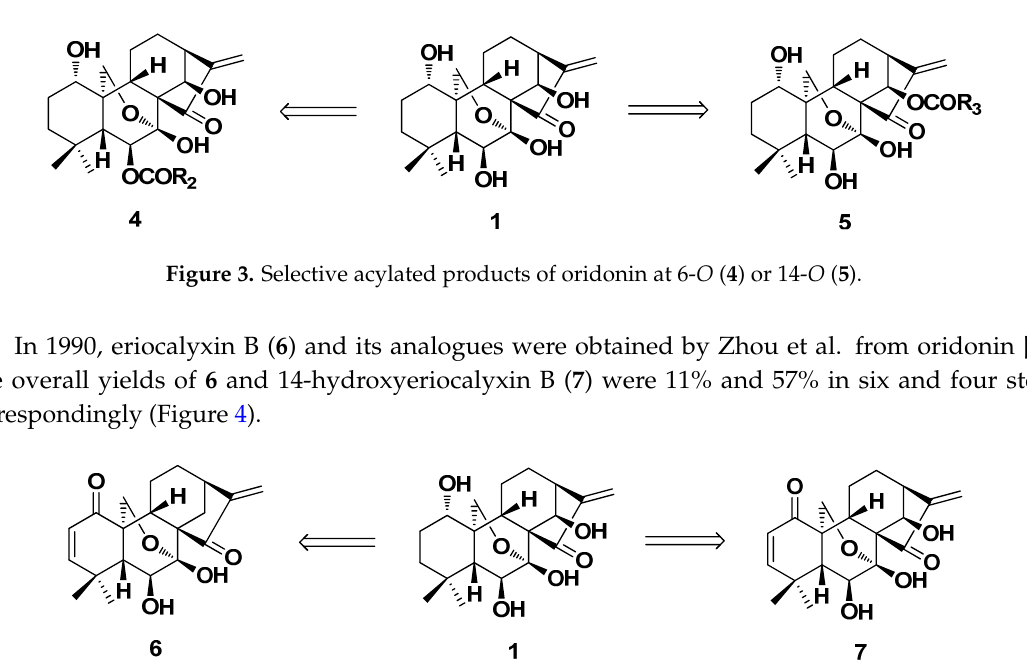
Figure 5. Synthesis of oridonin-6- O - α - D -glucopyranoside ( 8 ).